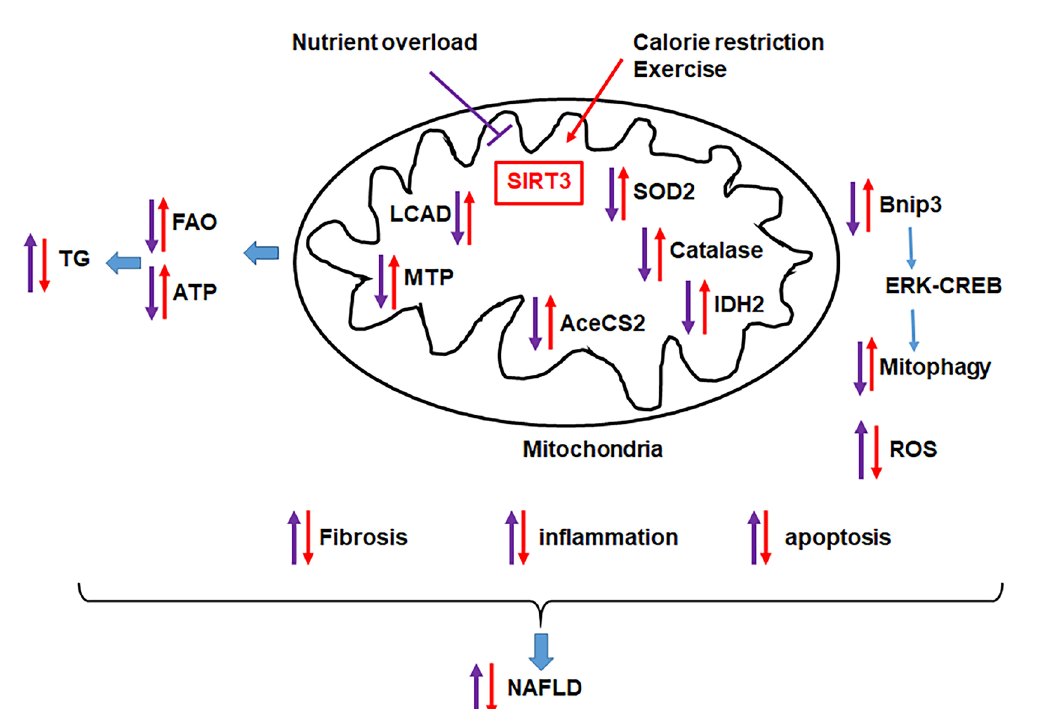
Figure 2. SIRT3 protects the liver from nutrient overload-induced NAFLD. Nutrient overload triggers metabolic reprogramming that leads to hepatic lipid accumulation and liver injury due to reduced mitochondrial function (FAO, ATP production), increased inflammation, reduced mitophagy. Factors that increase hepatic SIRT3, such as dietary restriction and exercise, counteract the effect of nutrient overload and improve